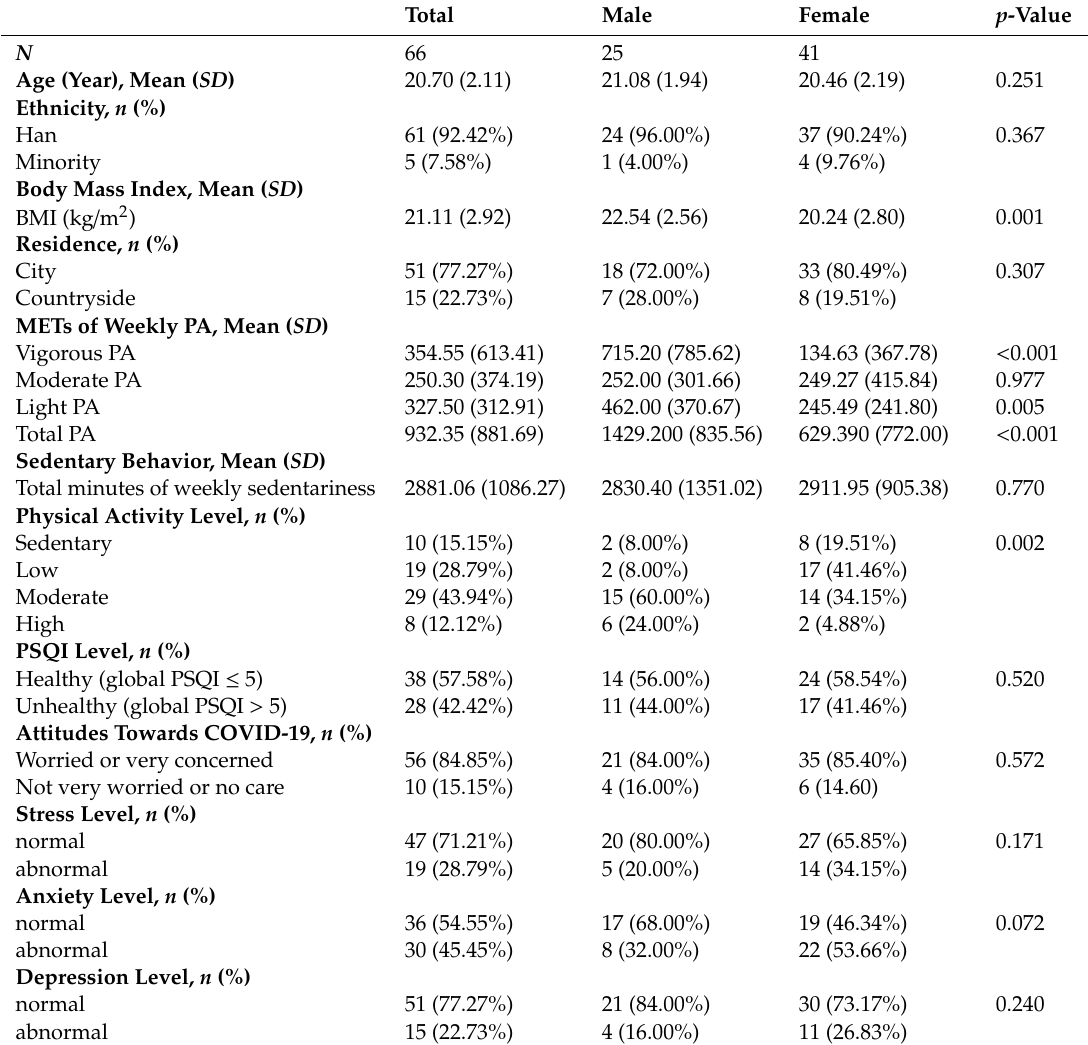
Table 1. Demographic characteristics and health status of all participants at